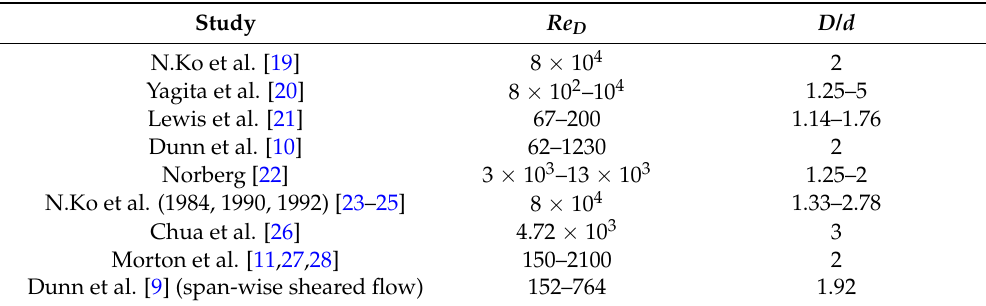
Table 1. Previous studies on flow behind step cylinders. Reproduced from